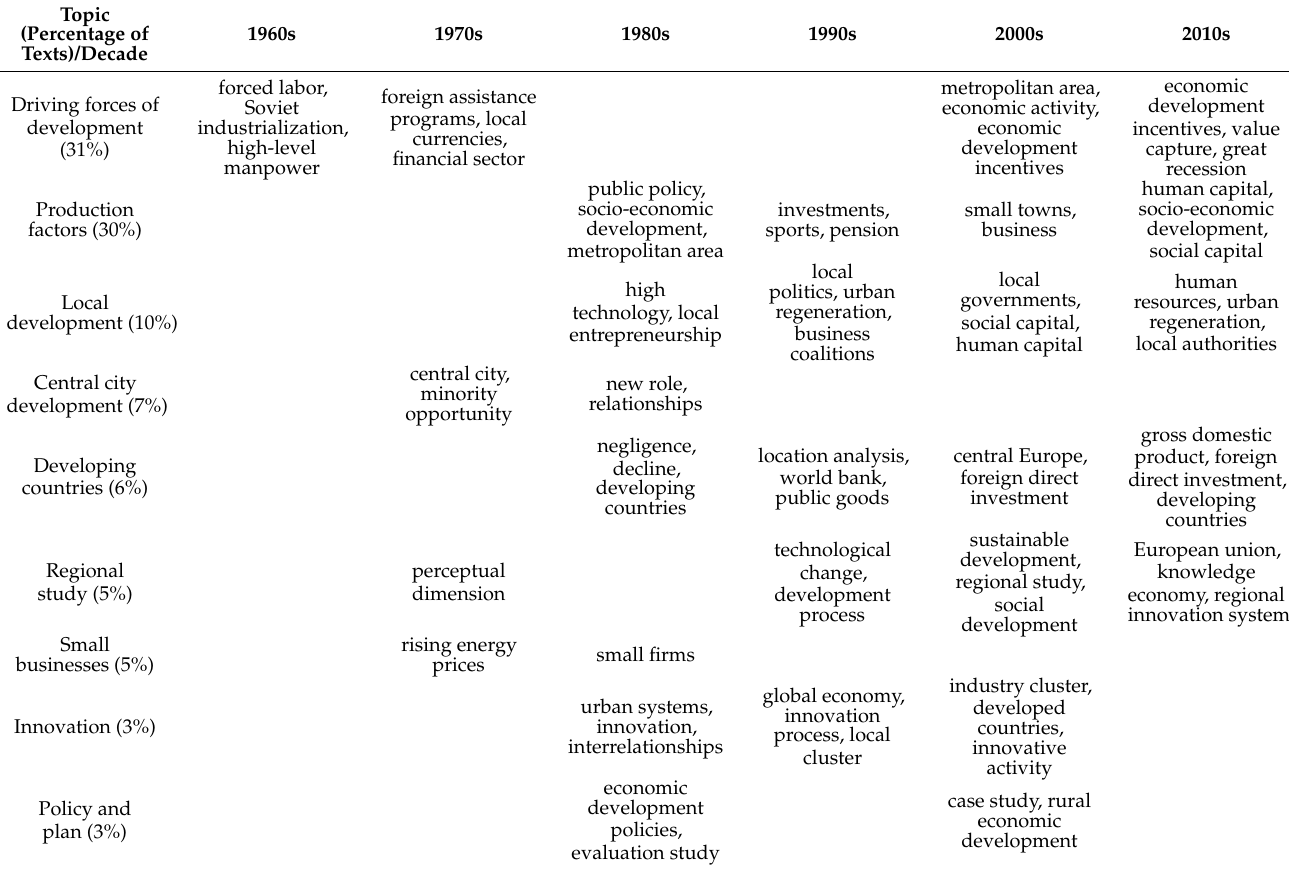
Table 1. Topic and topic keywords dynamics.